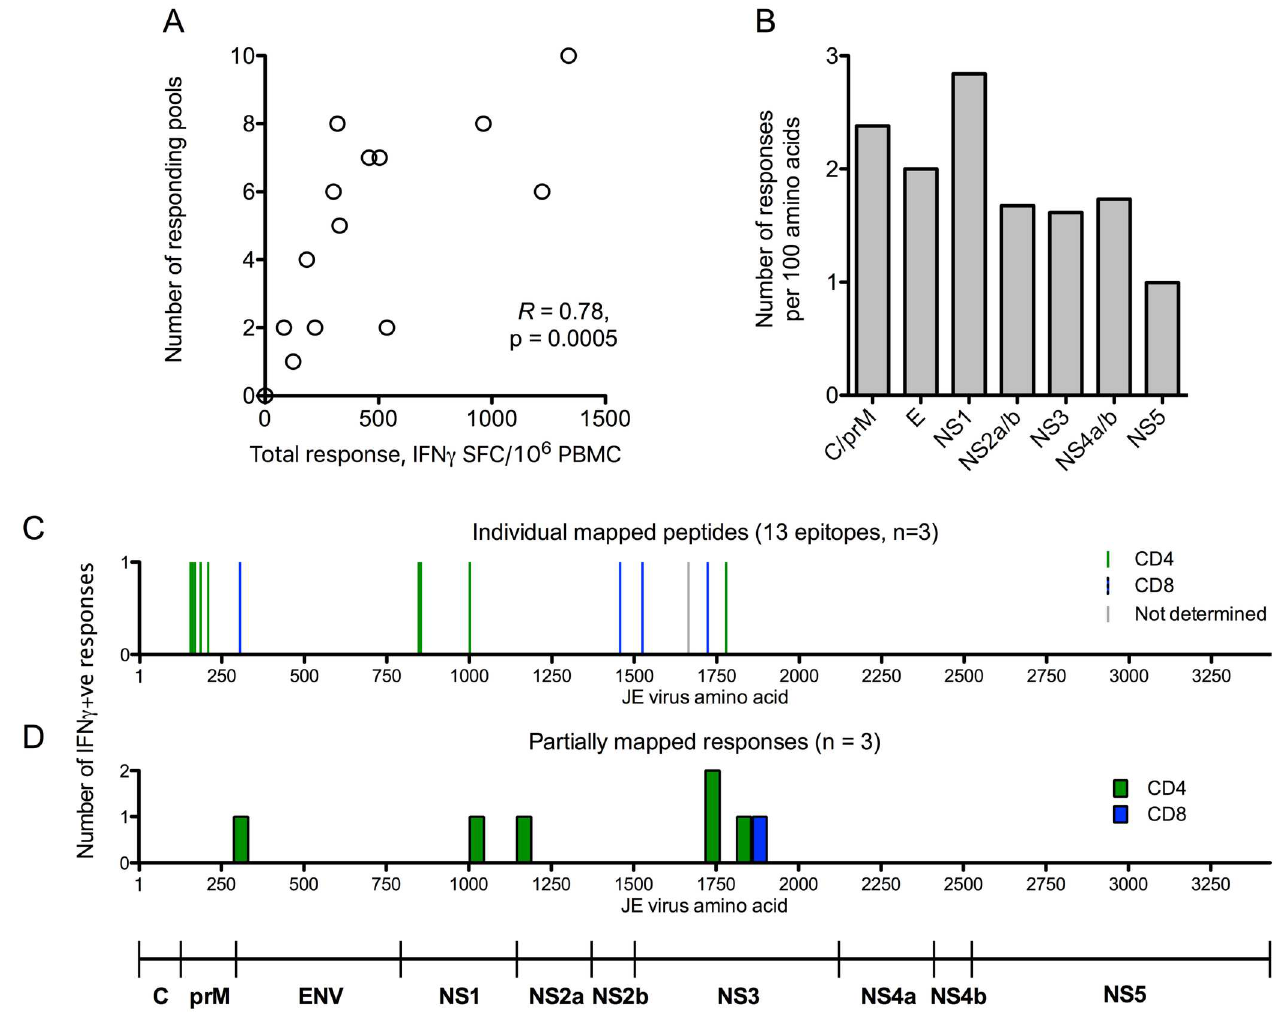
Fig 4. Targeting of IFN γ responses to JEV SA14-14-2. (A) Sum of all respondingpools (IFN γ SFC/10 6 PBMC by ELISpot) against the numberof respondingpools at the time of maximum ELISpot response per participant in the study. (B) Number of participantsrespondingto each protein of JEV in ELISpot assays, normalised to the protein size as responses per 100 amino acids. (C & D) Peptide pools were deconvoluted by ex-vivo ELISpot, or in ICS assays using T cell lines expanded to peptidepools. Locationof epitopes mappedto individual peptides (C) and to “mini-pools” spanningregions46–90 amino acids in size (D). The Y axes represent the number of responses identified(one of the six “mini-pool” regions identifiedwas recognised by two participants). Subsets were determined by flow cytometry. CD4 + responses: green bars; CD8 + responses: blue bars. The single grey bar in (C) depicts a responseidentifiedby ELISpot where the subset was not determined.